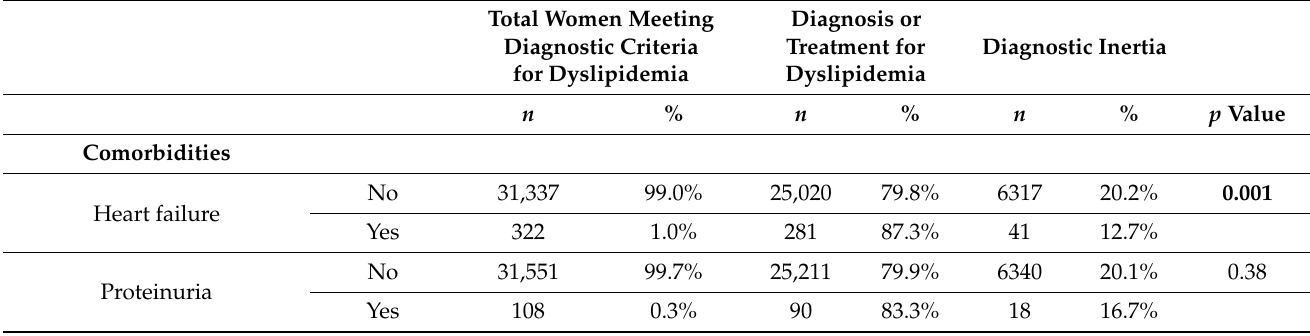
Table 4. Prevalence of diagnostic inertia in women according to comorbidities and